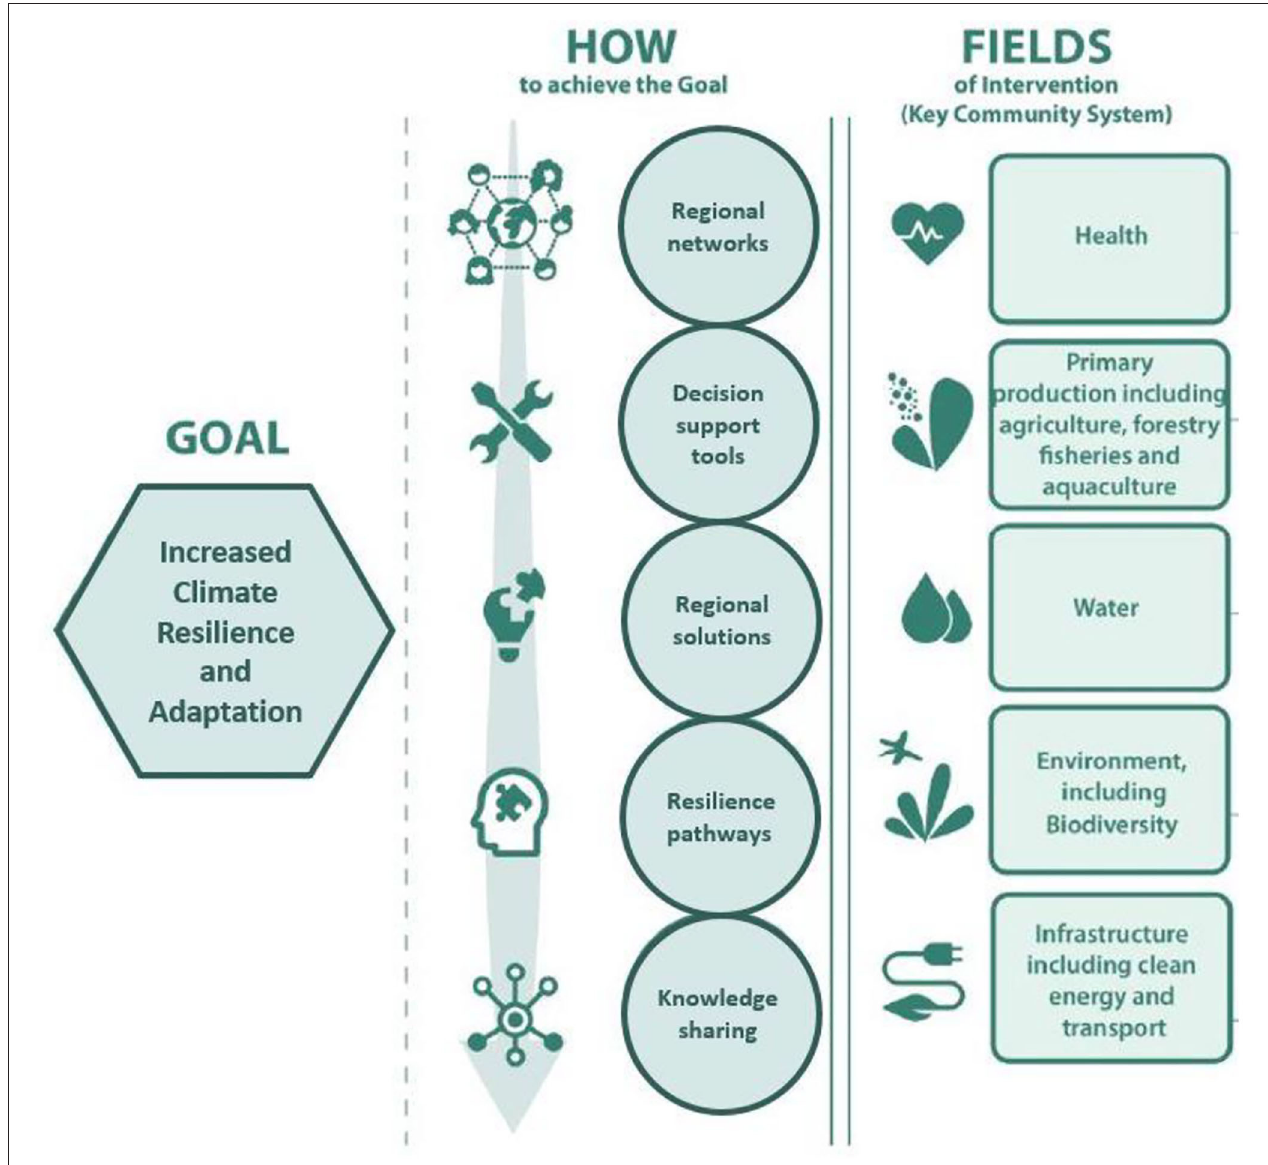
FIGURE 1 | Conceptual frameworks’ structure and